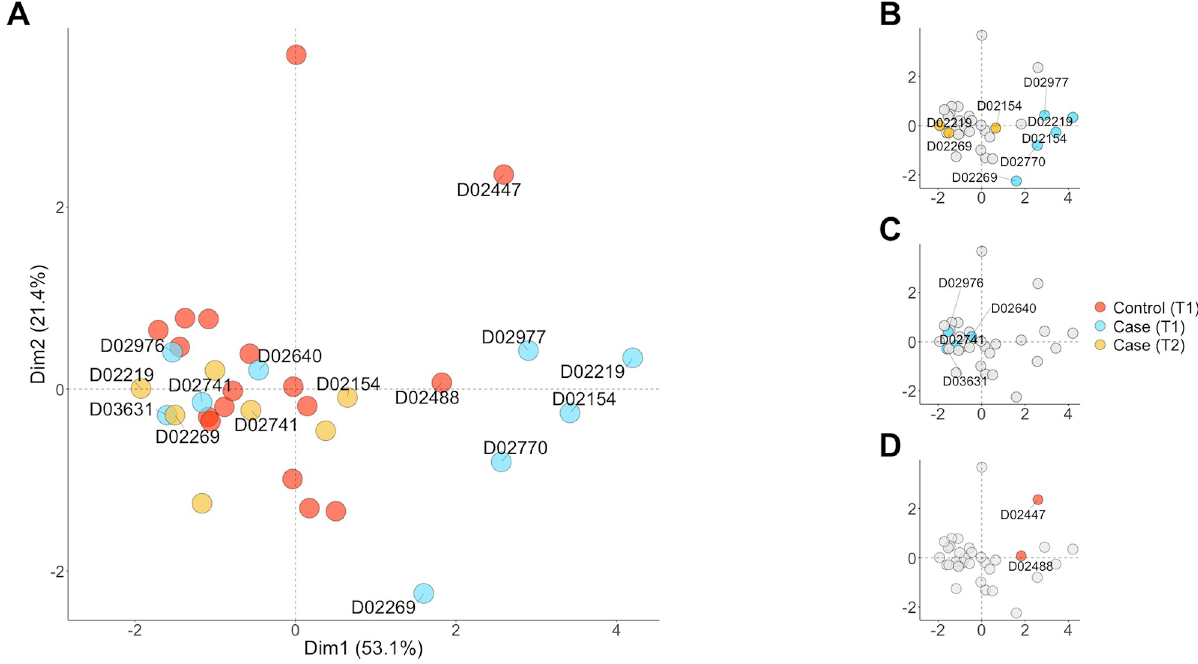
Fig 13. Principal component analysis for IGH. (A) All controls and T1 and T2 cases passing filtering criteria. (B) T1 cases are highlighted that follow expectation (i.e. appear clonal based on the frequency of a single clone at T1) with paired T2 clonal reduction for samples with both time points. (C) T1 cases that are grouped with the majority of controls. (D) Two controls that are grouped near clonal cases highlighted in panel A.